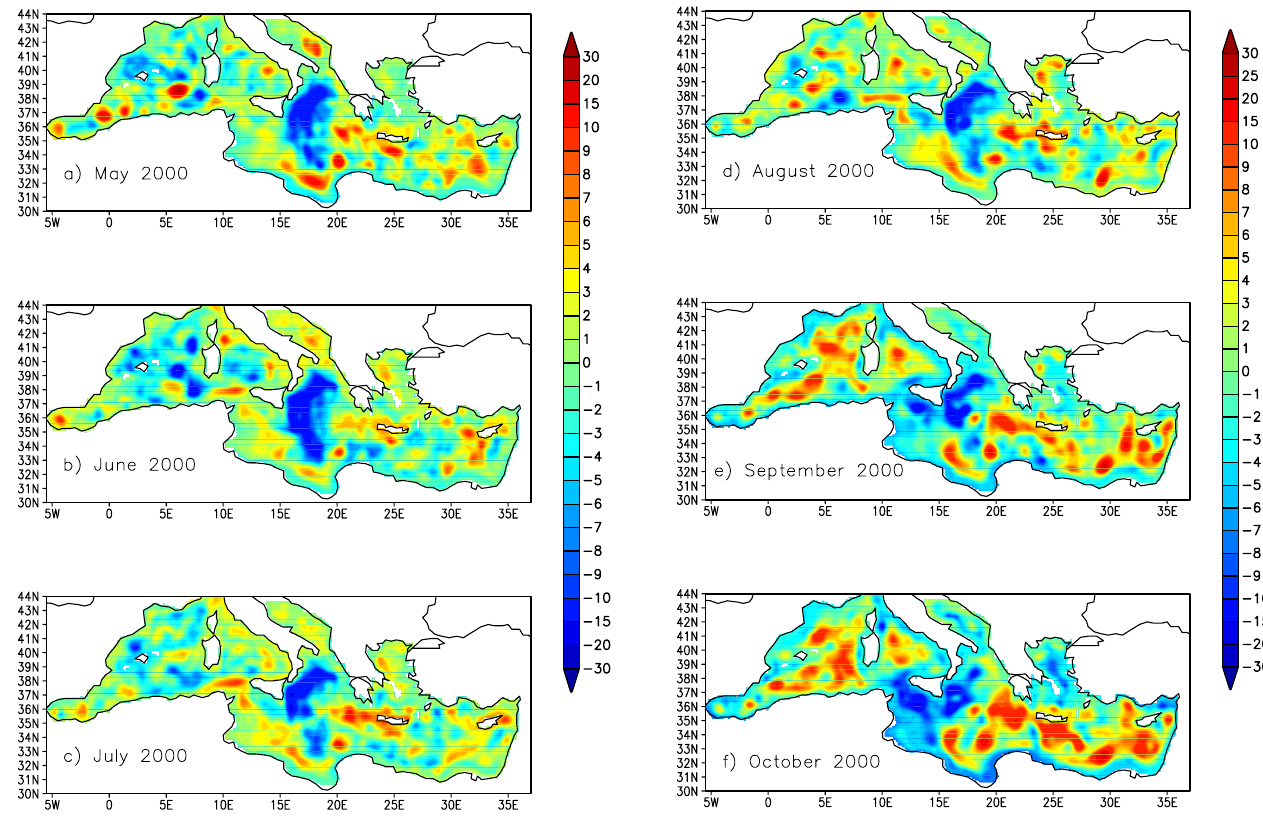
Fig. 6. Monthly mean of MFSPP SLA analysis in cm for (a) May 2000, (b) June 2000, (c) July 2000, (d) August 2000, (e) September 2000, (f) October